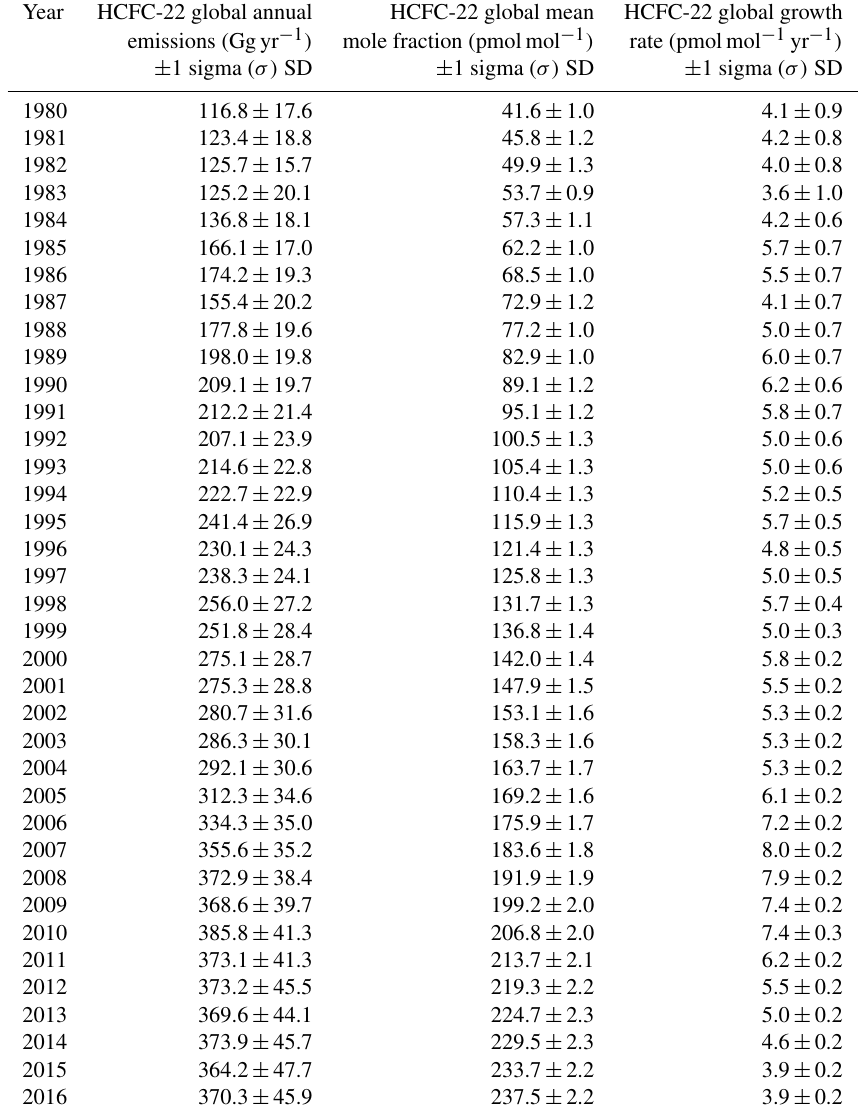
Table 3. Annual mean global HCFC-22 emissions, mole fractions, and growth rates, derived from the AGAGE 12-box